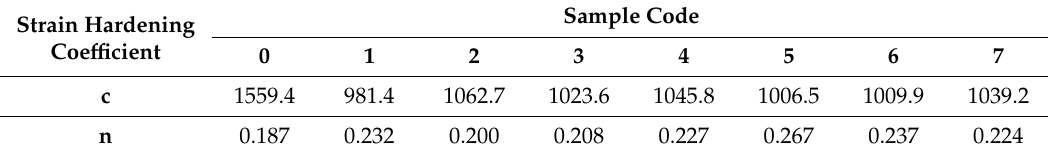
Table 2. Strain-hardening coe ffi cients estimated for tested heat treatment schemes.